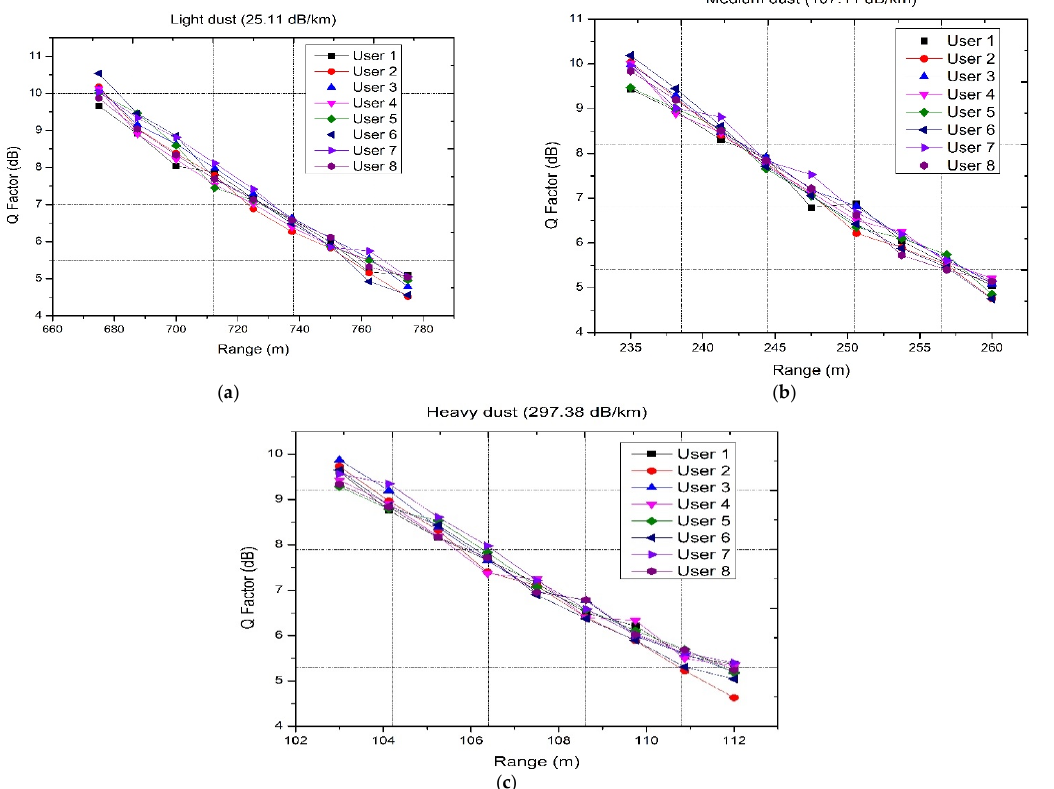
Figure 10. Q-factor of FSO-PDM/PV-OCDMA system versus FSO link under ( a ) LD, ( b ) MD, and ( c ) HD. Table 5. log (BER) values and Q-factors of eight channels of FSO-PDM/PV-OCDMA system under dust storm conditions and propagation ranges.